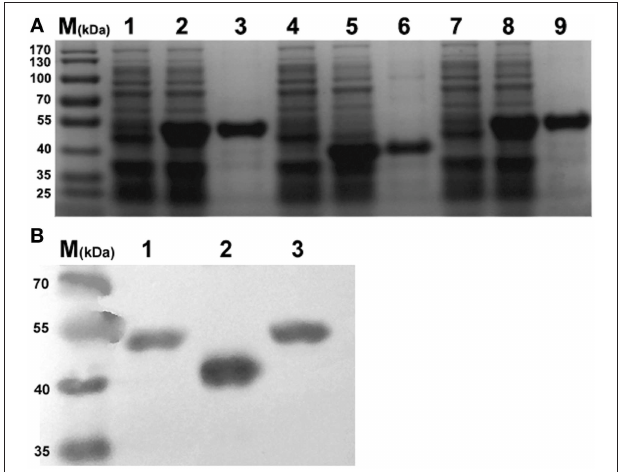
FIGURE 1 | SDS-PAGE and Western-blot identification of recombinant Eno1, Bgl2, and Pgk1. (A) SDS-PAGE identification. Lanes: 1, pET30a-Pgk1 in E. coli BL21; 2, pET30a-Pgk1 in E. coli BL21, induced by IPTG; 3, purified recombinant Pgk1(46kDa); 4, pET30a-Bgl2 in E. coli BL21; 5, pET30a-Bgl2 in E. coli BL21, induced by IPTG; 6, purified recombinant Bgl2(33–37kDa); 7, pET30a-Eno1 in E. coli BL21; 8, pET30a-Eno1 in E. coli BL21, induced by IPTG; 9, purified recombinant Eno1(47kDa). Molecular markers (in kDa) of standard proteins are to the left. (B) Identity the recombinant Pgk1(lane 1), Bgl2(lane 2), and Eno1(lane 3) by Western blotting using peroxidise -conjugated 6 × His monoclonal antibody, Molecular markers (in kDa) of standard proteins are to the left.